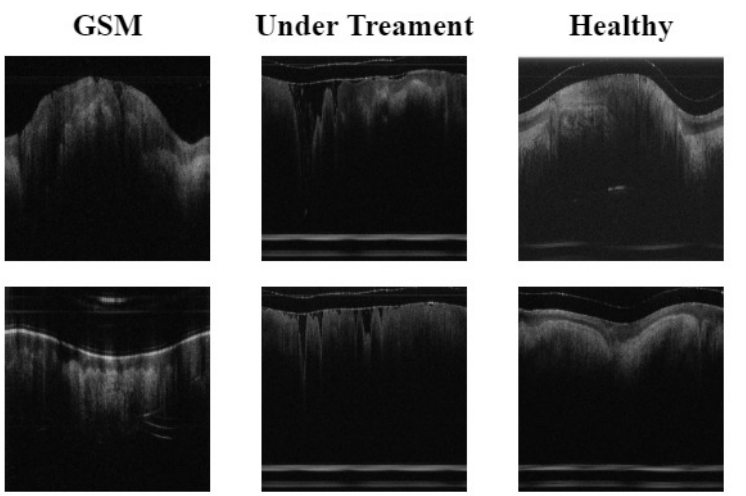
Figure 2. OCT images of Genitourinary syndrome of menopause (GSM), Under Treatment (UT), and Healthy